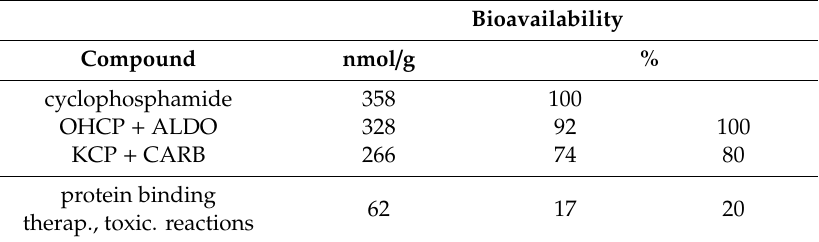
Table 1. Balance of cyclophophamide metabolism in female NMRI mice after the intravenous The 2nd column in the % column indicates how much of the OHCP formed is oxidized to KCP and Carb.